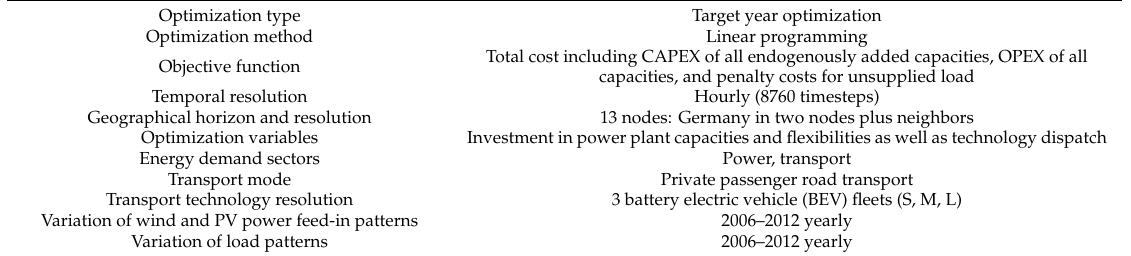
Table A1. Model characteristics of REMix as used in this case